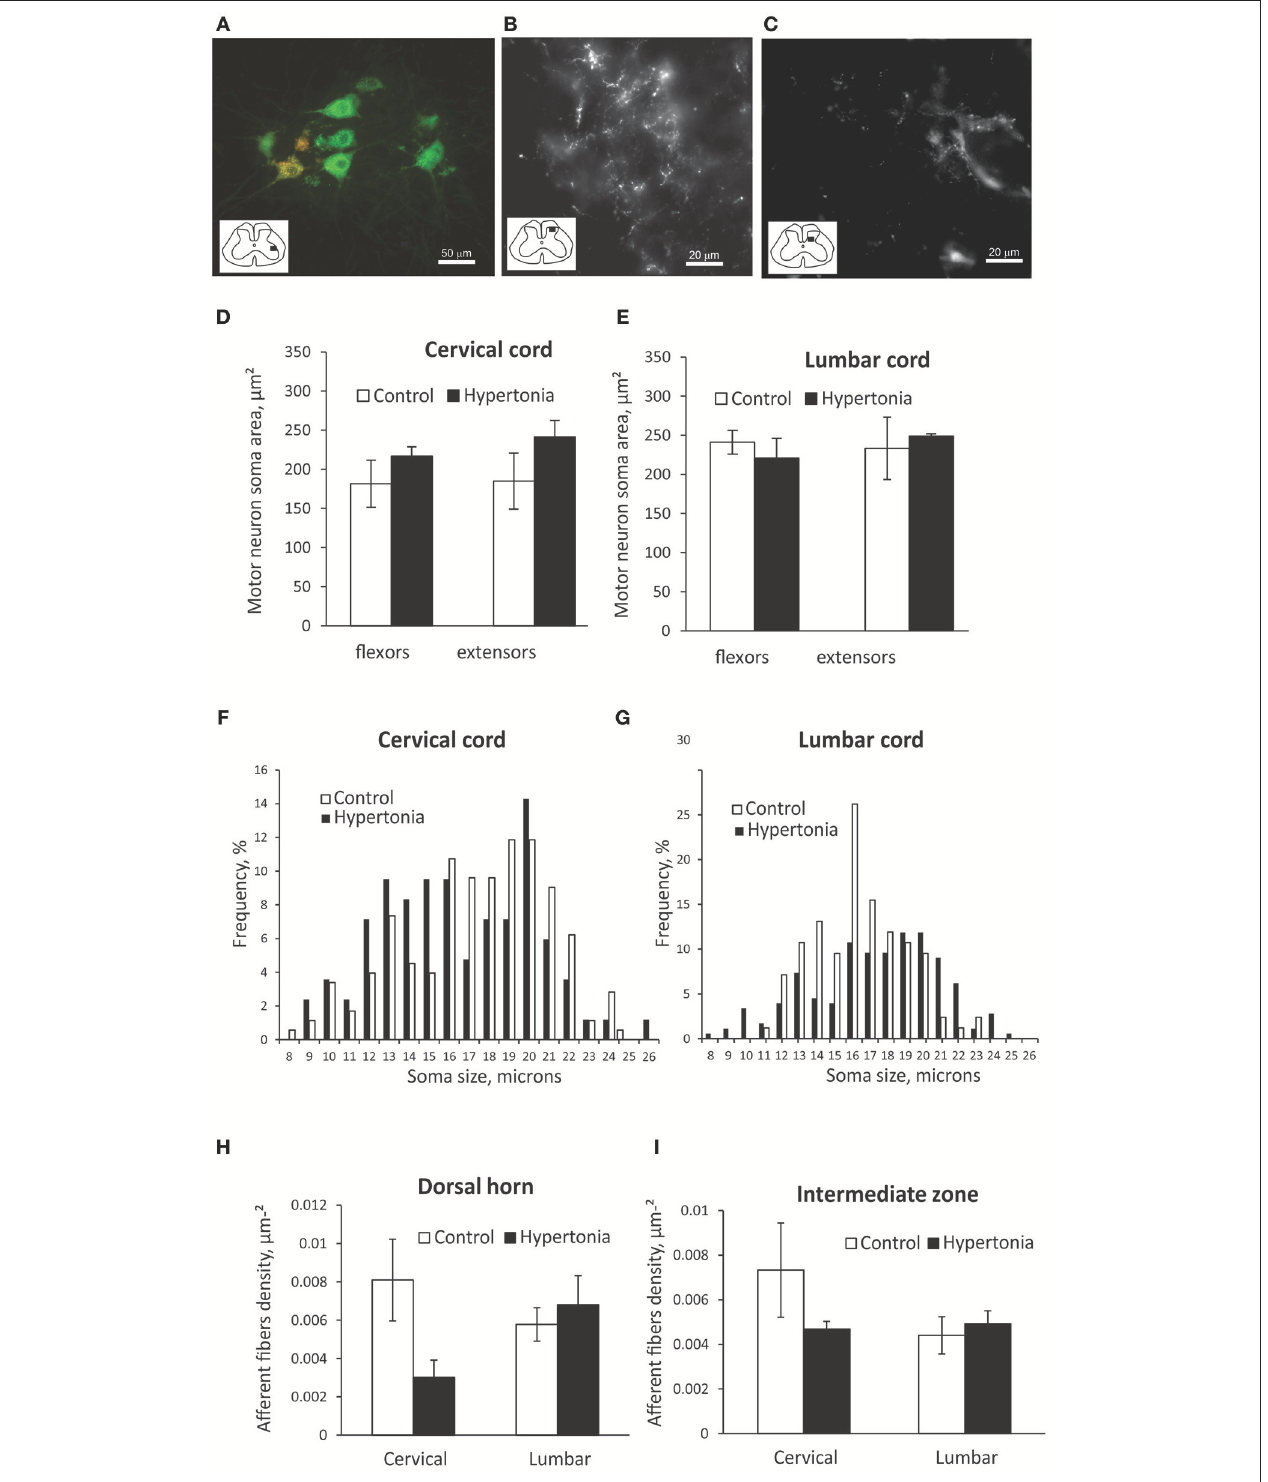
FIGURE 6 | Labeling of motor neurons and primary afferents by intramuscular injection of CTB in newborn kits. Retrograde neuronal tracer cholera toxin B conjugated with different color fluorophores (orange and green) was injected in flexor and extensor muscle groups in wrist and ankle at P1 kits and cords were collected after 2 days. (A) Labeled motor neurons in ventral horn of cervical cord. Orange label is from wrist flexors and green label is from wrist extensor injection. Stereological estimation of motor neuron soma size is on (D,E) and distribution of sizes (F,G) . Primary afferents labeling in dorsal horn (B) and intermediate zone (C) and stereological estimation of fiber density (H,I) . Inserts in (A–C) show spinal cord diagrams indicating locations where high magnification picture were taken.